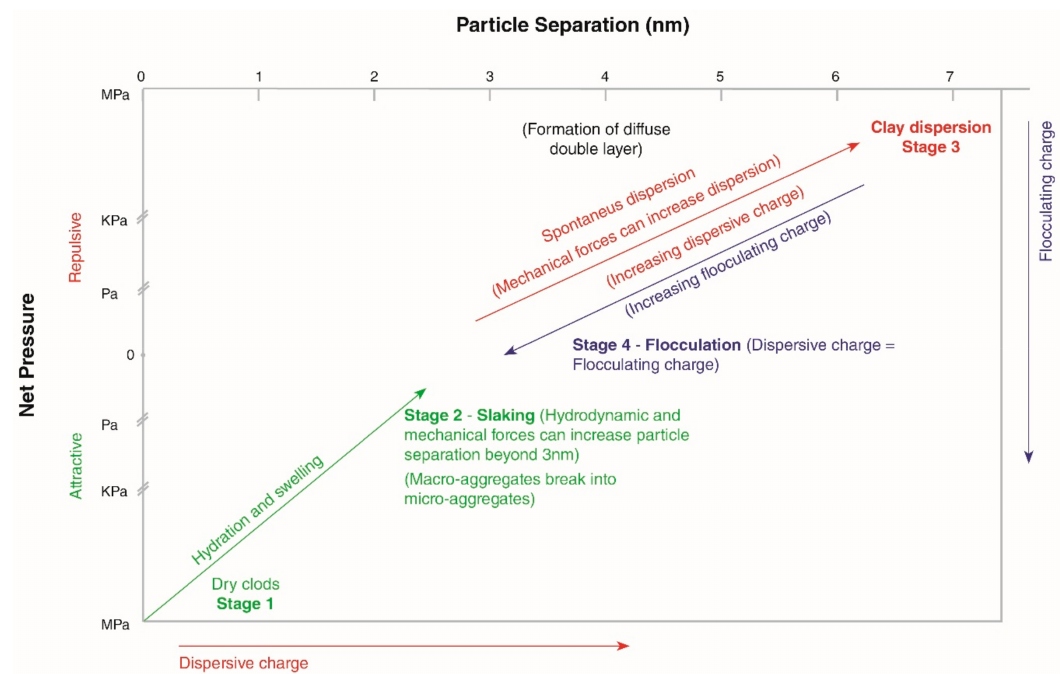
Figure 1. Particle separation from soil aggregates on wetting due to net pressure generated by dispersive and flocculating